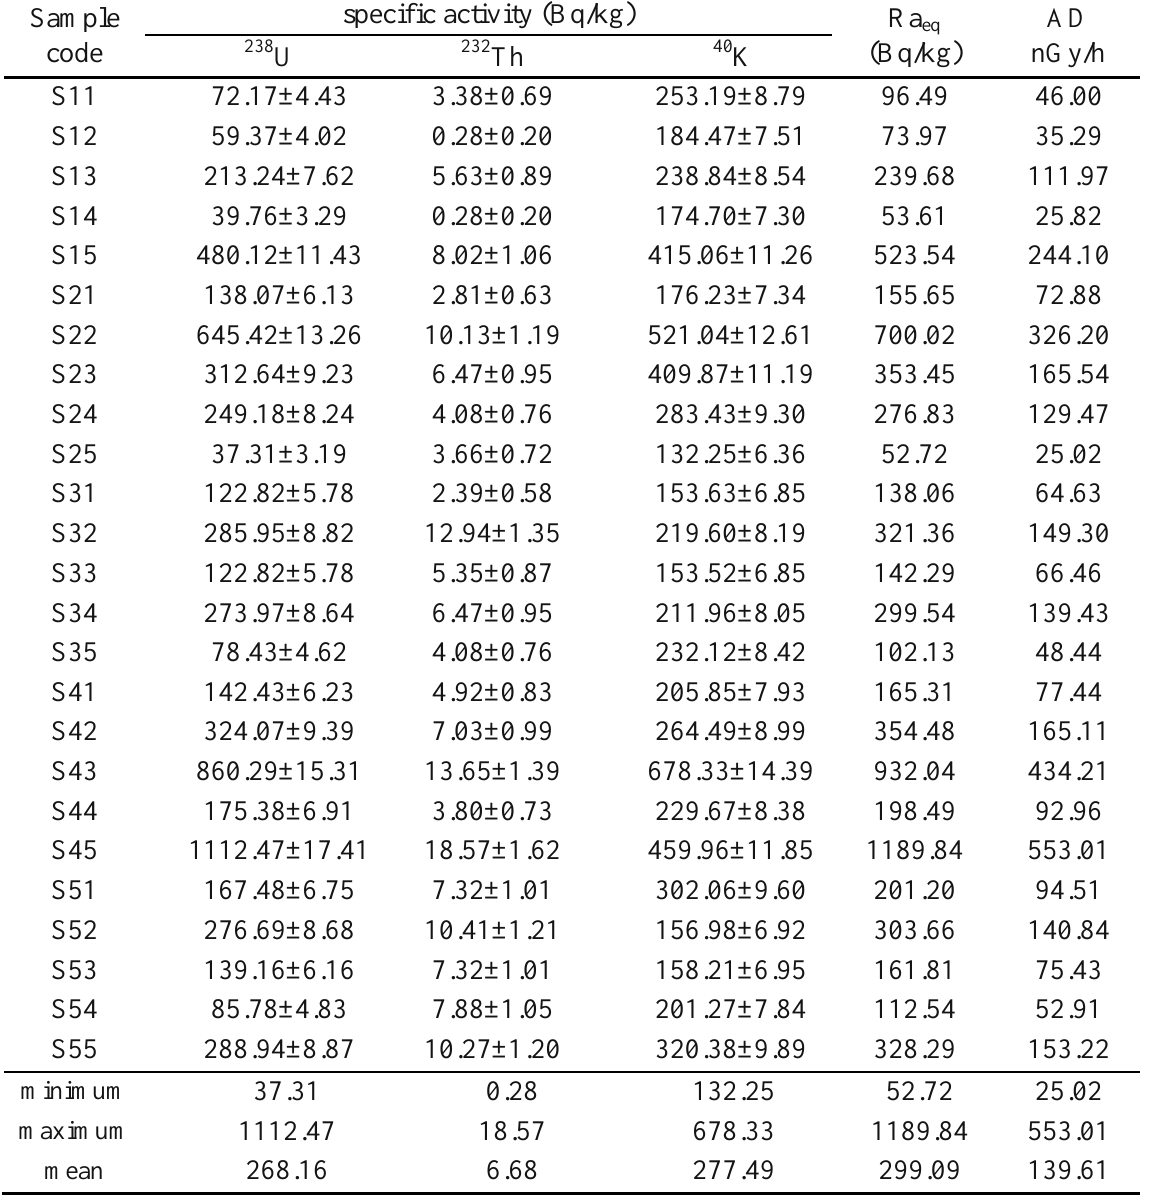
Table 1: Specific activity, radium equivalent activity and absorbed